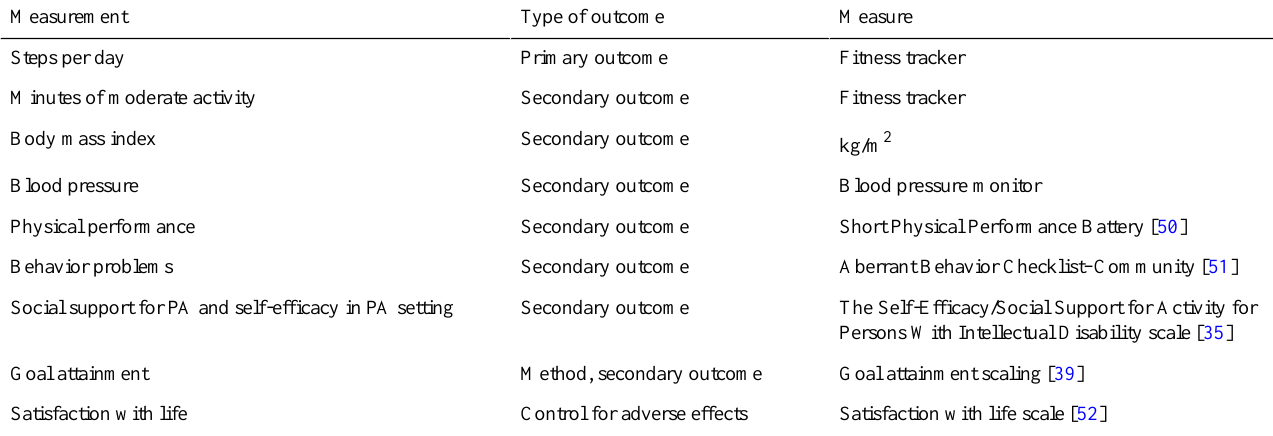
Table 1. Summary of outcome